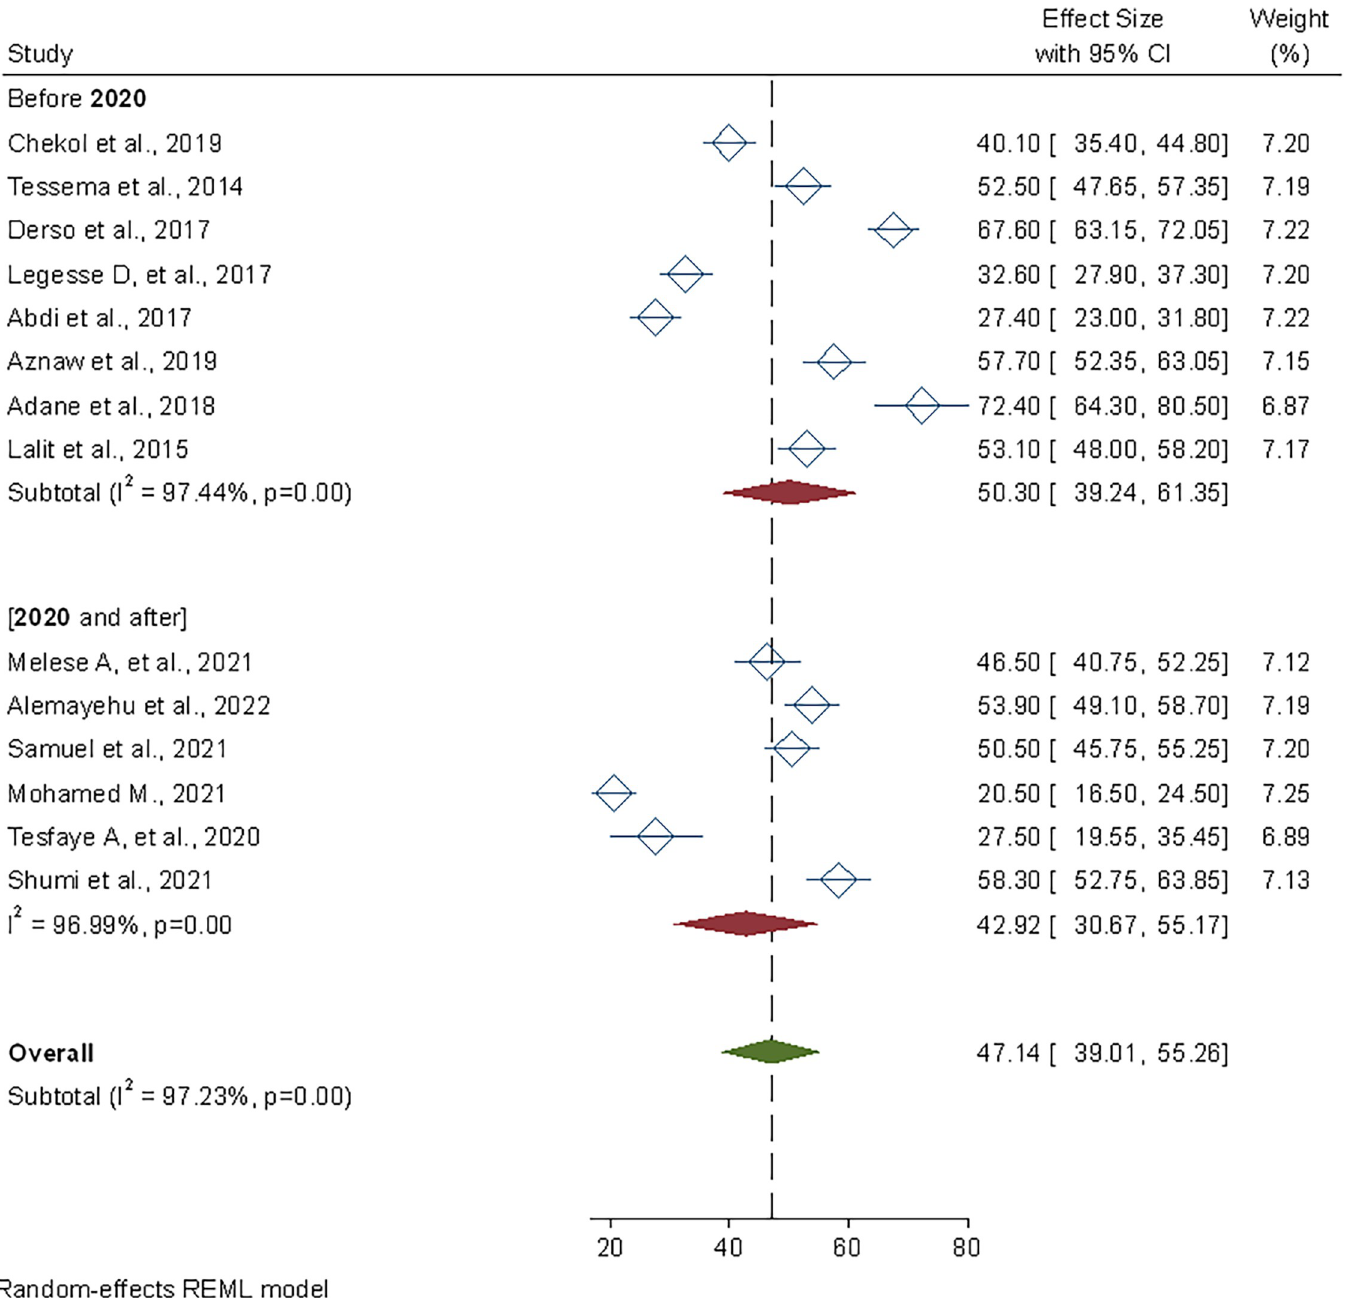
Fig 3. Sub-group pooled prevalence estimate of safe food handling practices by study year among food handlers in foodservice establishments of Ethiopia, 2022.